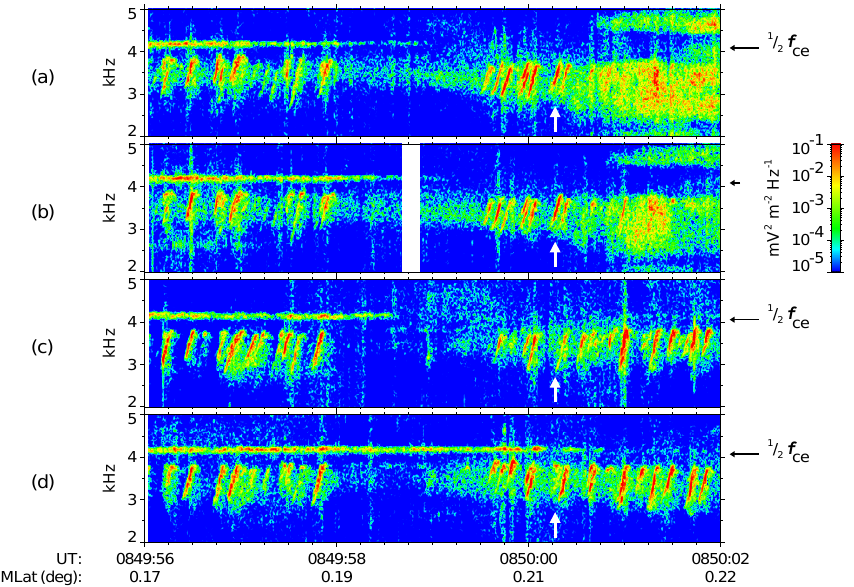
Fig. 2 . Fig. 2. Spectrograms (i.e. dynamical spectra) of lower band chorus at frequencies below half the local electron gyrofrequency as indicated, as observed on all four Cluster satellites, measured by the Wide Band Detector (WBD) electric field instrument at an L-value=4.4, for six seconds at a Universal Time of 08:49:56 on 18 April 2002. MLat shows the magnetic latitude; these observations are made very close to the geomagnetic